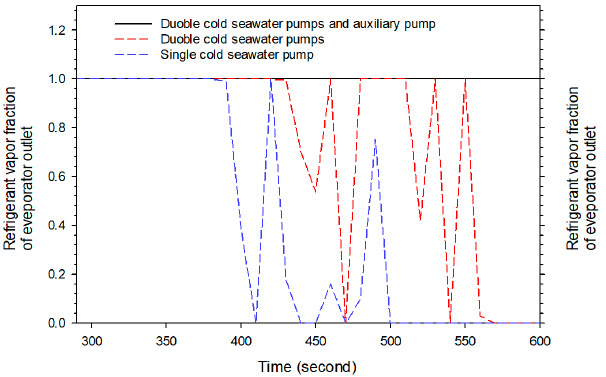
Figure 13. Vapor fraction of the refrigerant according to the type of cold pump used.